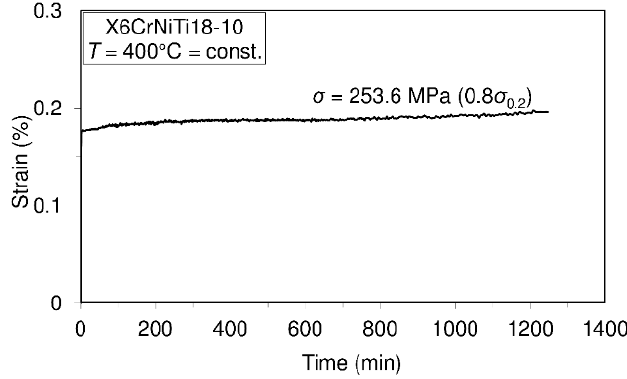
Figure 5. Creep behavior of steel X6CrNiTi18-10 at the temperature of 400 °C.